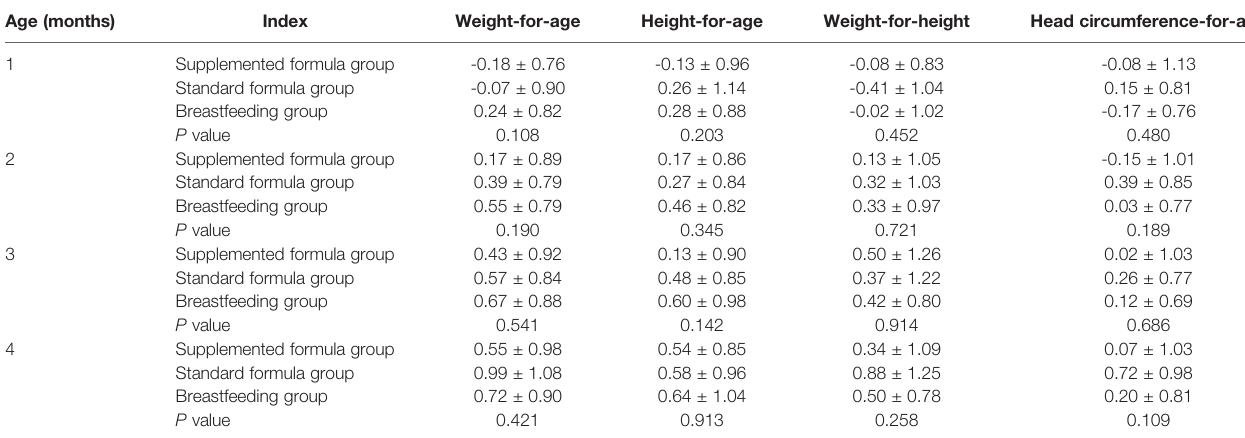
TABLE 2 | Growth conditions of the participants.